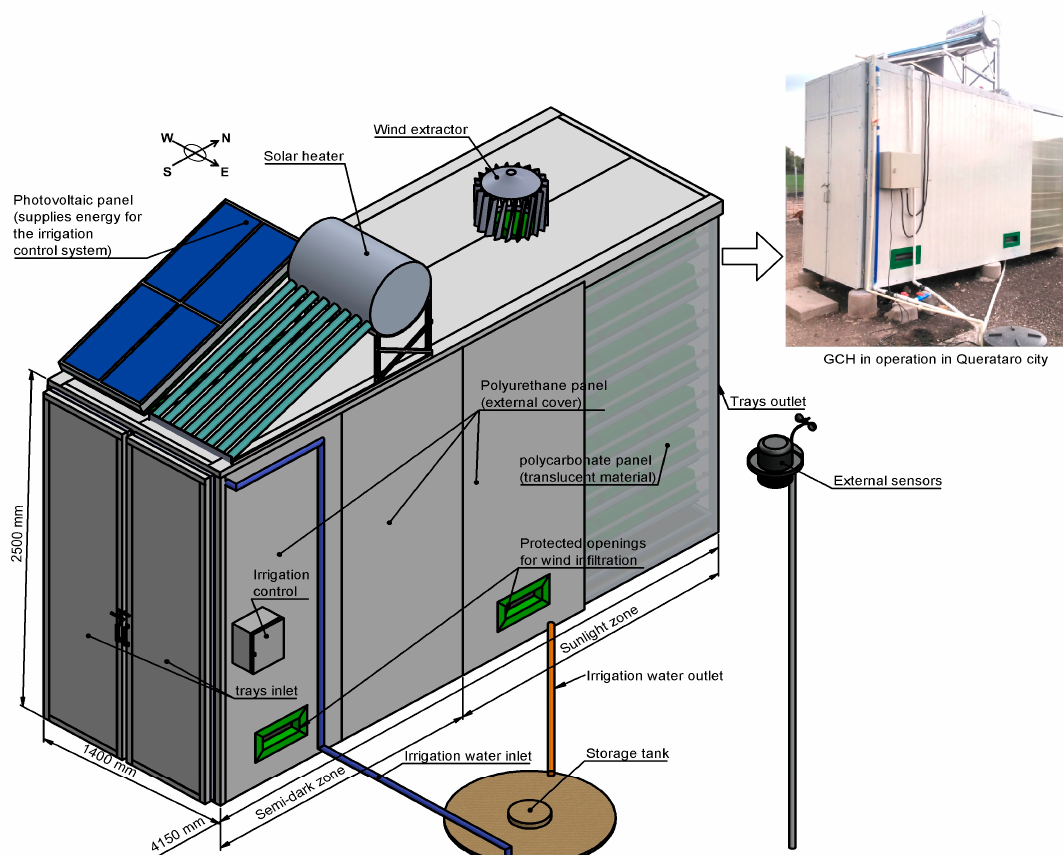
Figure 1. Schematic of the experimental setup of the growth chamber used to produce hydroponic green forage.